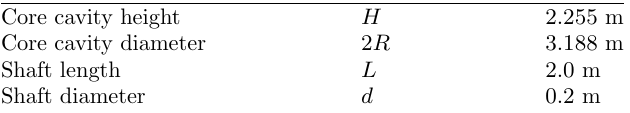
Fig. 1. Simplified geometry of the fuel circuit for the zero dimen- sional model. (a) The molten salt evolution is represented by the quantity h ( t ) , i.e. the distance of the salt free surface from the cavity upper surface. (b) A time-varying control volume (in red) is adopted to describe the draining phenomenon. Table 1. Model domain dimensions [5].